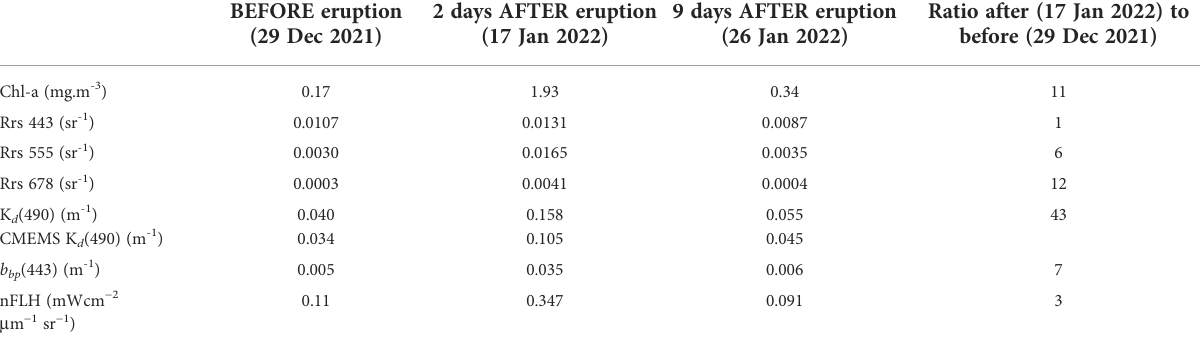
All spectral and IOP data in this table were obtained from MODIS products.